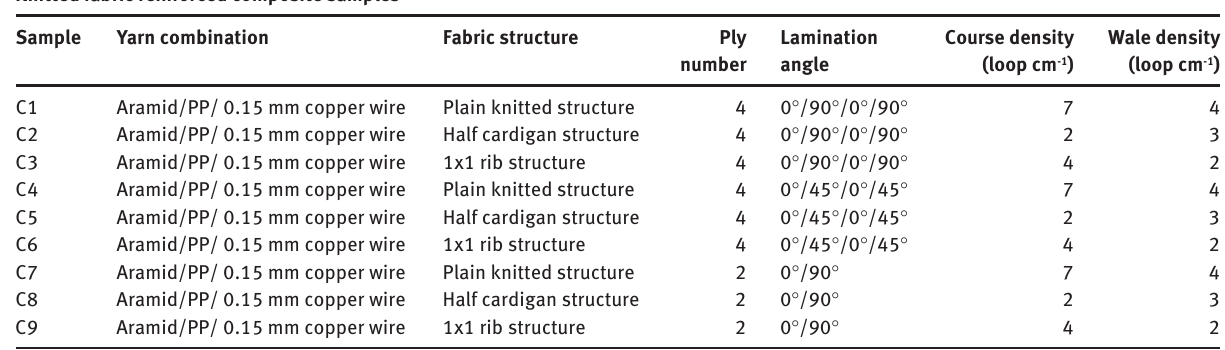
Table 2 Knitted fabric-reinforced composites. Knitted fabric reinforced composite samples